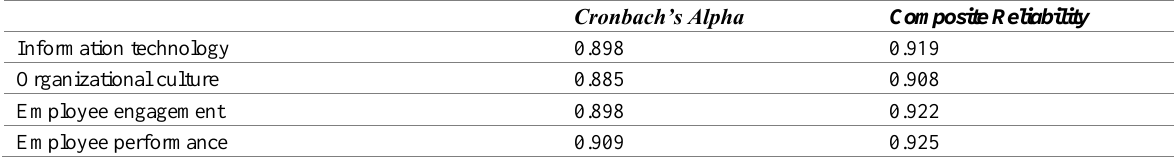
Table 4 : Reliability Analysis